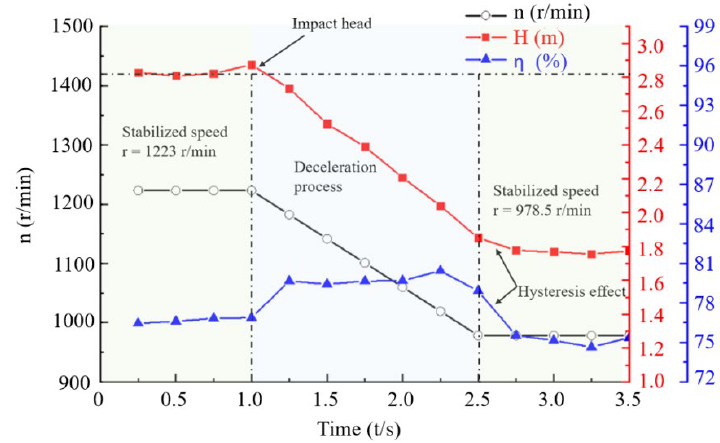
Figure 8. Transient external characteristic